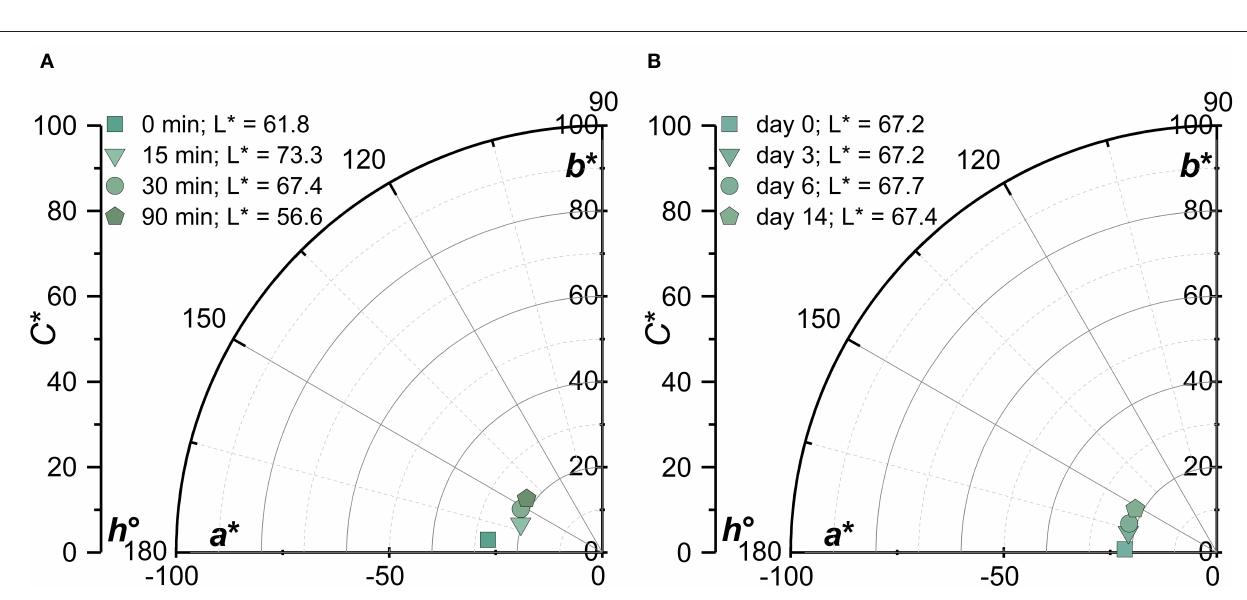
Effect on Transmittance and Absorption (Carle and Schweiggert, 2016). To quantify the color degradation, transmittance and absorption measurements were carried out ( Figure 4 ). In addition, the color